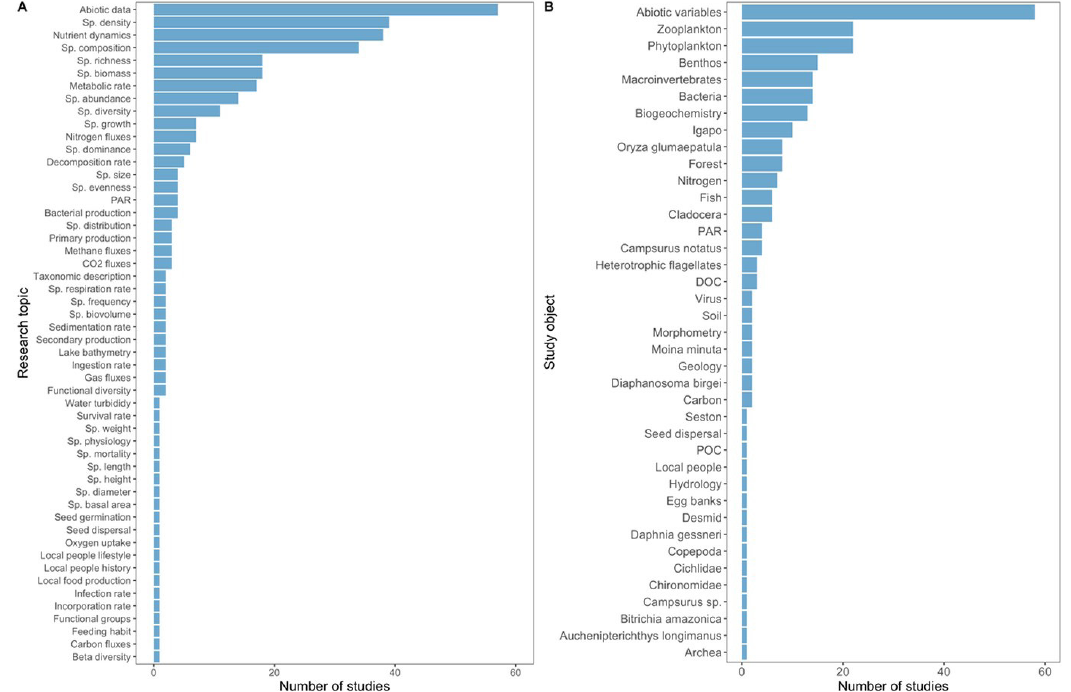
Figure 4. Histogram of the most (A) Research topics and (B) Study objects described in the published papers and book chapters included in the systematic review. Acronyms are Sp. = Species, PAR = Photosynthetically active radiation, DOC = dissolved organic carbon, POC = particulate organic